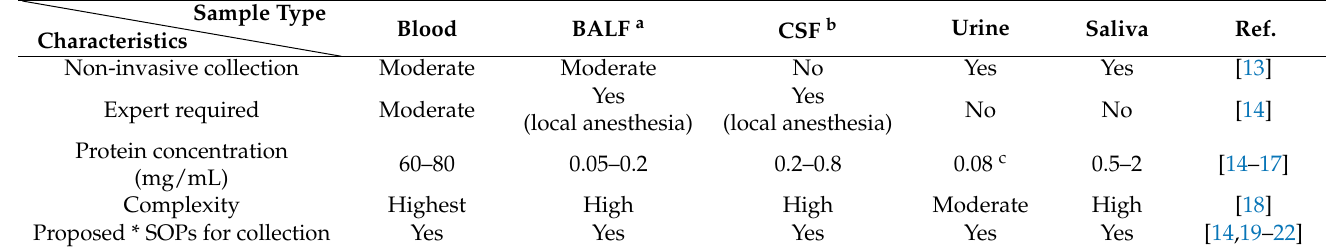
Table 1. Characteristics of body